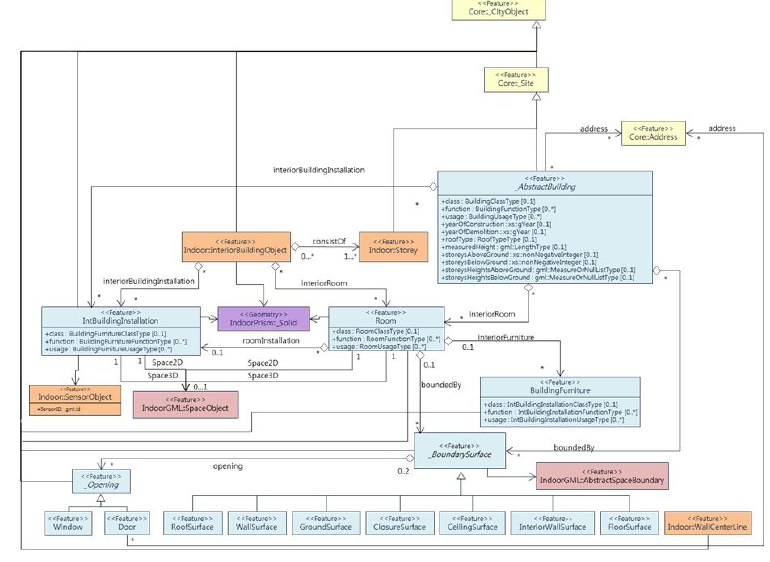
Figure 6. Indoor Building Part